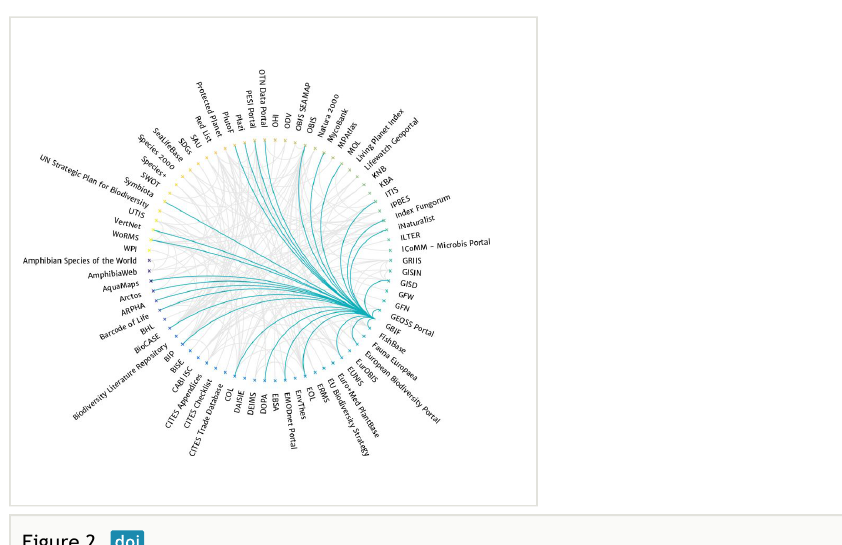
Figure 2. A highly-connected element in the landscape: the Global Biodiversity Information Facility